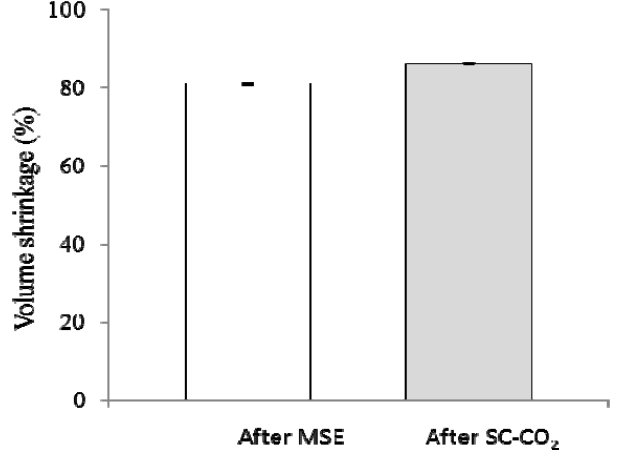
Figure 3. Volume shrinkage of WEAX hydrogel during drying process.